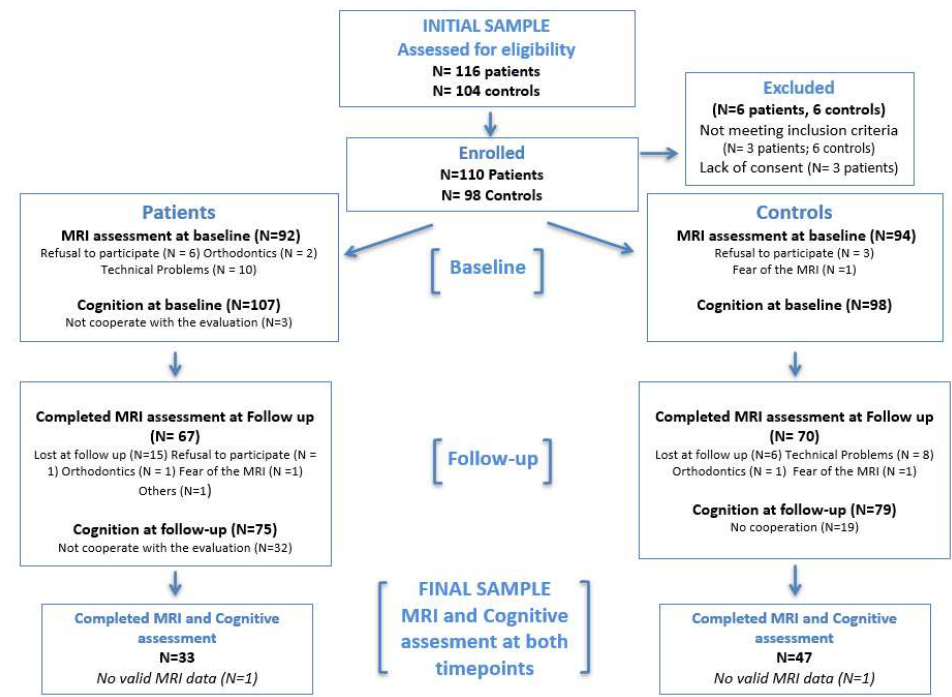
Figure 1. Flowchart for completers and non-completers. Non-completers are participants for whom we do not have a baseline or follow-up cognitive or magnetic resonance imaging data, or from whom the data were not good enough to be used for the study.